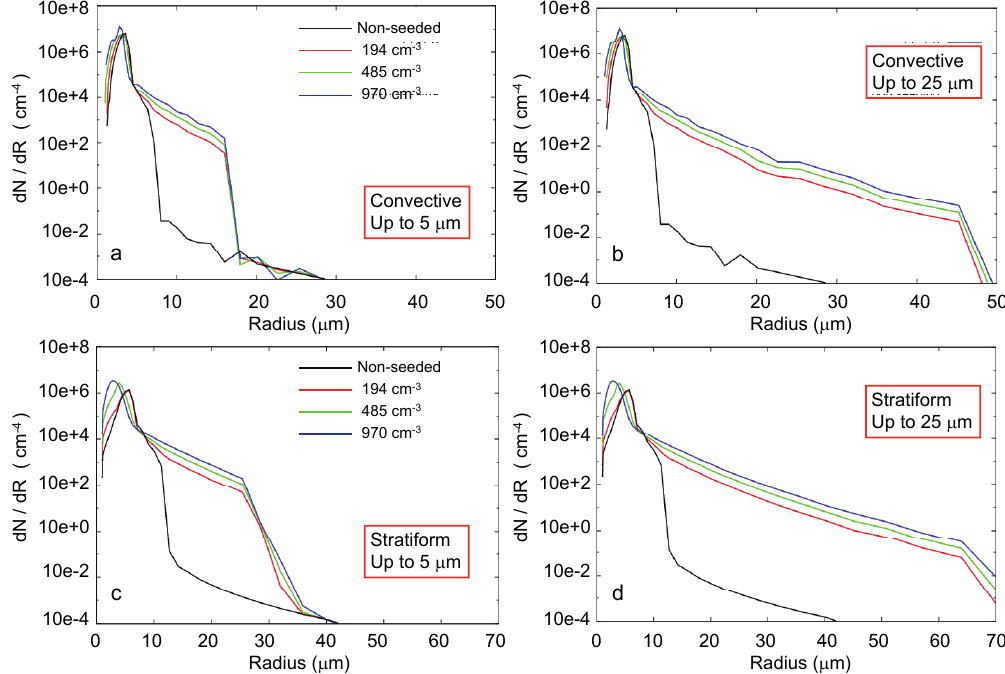
Fig. 11. Cloud droplet size distributions at 100m above the base of the cloud center for the shallow convective cloud case (updraft velocity is about 4ms − 1 ) at 11.5min (a) and (b) and for the stratiform cloud case (updraft velocity is about 0.3ms − 1 ) at 68.5min (c) and (d) . Numerical simulations are performed with flare particles with radii up to 5µm (a) and (c) or up to 25µm (b) and (d). The black line indicates the size distribution for the non-seeded case. For seeded cases, different total number concentrations of flare particles are seeded under the cloud base: 194cm − 3 (red line), 485cm − 3 (green line), and 970cm − 3 (blue